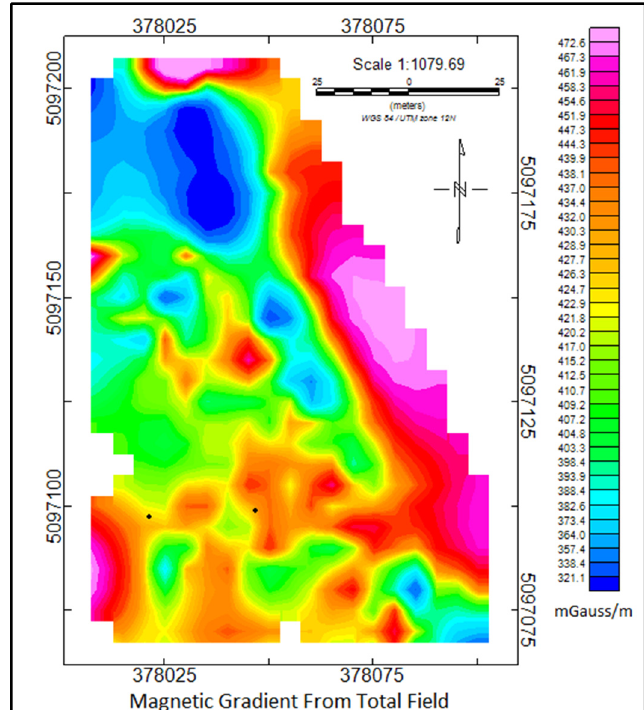
Figure 6. The vertical magnetic gradient between the two magnetometers, calculated from each magnetometer’s total field.